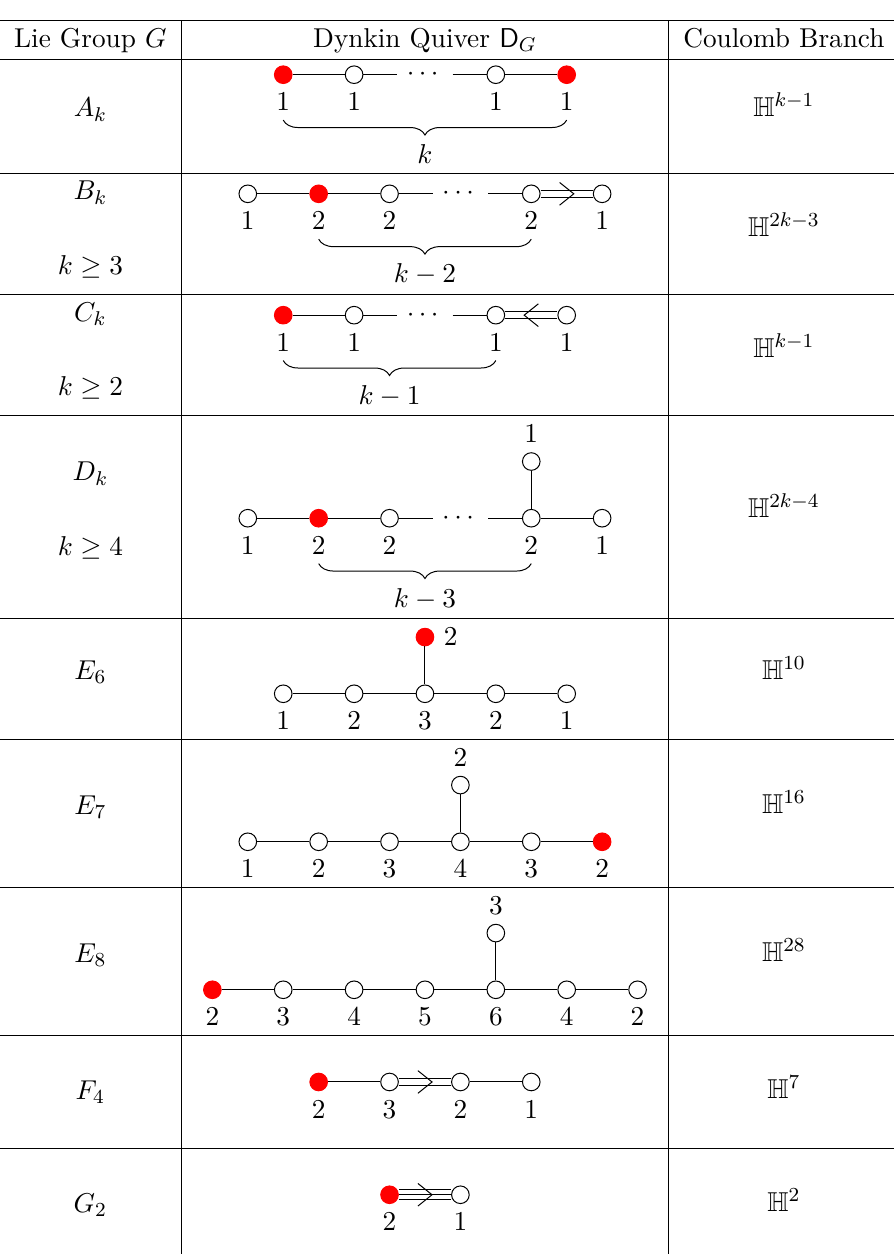
Table 1 . Dynkin quivers of finite type. The quiver in the central column is the Dynkin quiver for the Lie group in the left-hand column. The Coulomb branch variety of this quiver, after ungauging the diagonal U (1) , is listed in the right hand column. Red nodes are those which are unbalanced. All unbalanced nodes in this table have an excess of − 1